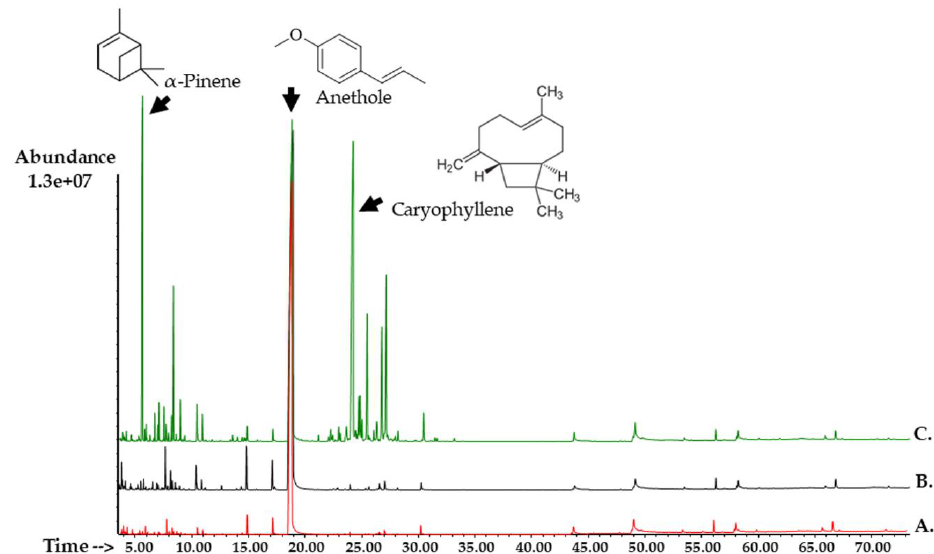
Figure 3. GC-MS Chromatogram of ( A ) Clausena excavata leaves in essential oil ( B ) Clausena harmandiana leaves in essential oil and ( C ) Murraya koenigii leaves in essential oil.